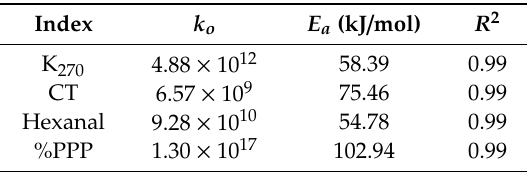
Figure 3. Arrhenius plot of apparent zero-order rate constants of K270, CT and %PPP. Table 3. Frequency factor ( k 0 ), activation energy ( E a ) and corresponding regression parameters of K270, CT, hexanal and %PPP in